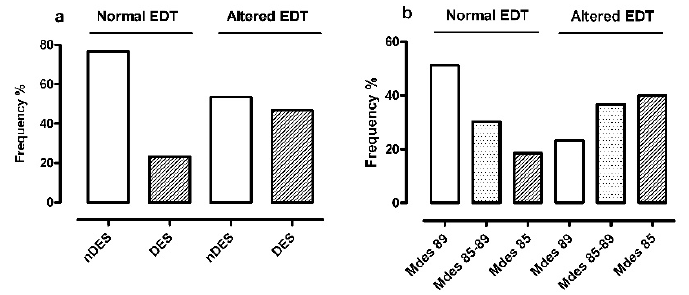
Figure 4. Frequency distribution of nDES / DES classes( a ) and of Mdes severity classes ( b ) in relation to normal / altered EDT. Legend: EDT = trans-tricuspid E-wave deceleration time; DES = oxygen desaturators; nDES = non oxygen desaturators; Mdes = mean desaturation peak values of nocturnal events; Mdes 89 = Mdes ≥ 89% = mild group; Mdes 85–89 = Mdes < 89% and > 85% = moderate group; Mdes 85 = Mdes ≤ 85% = severe group.